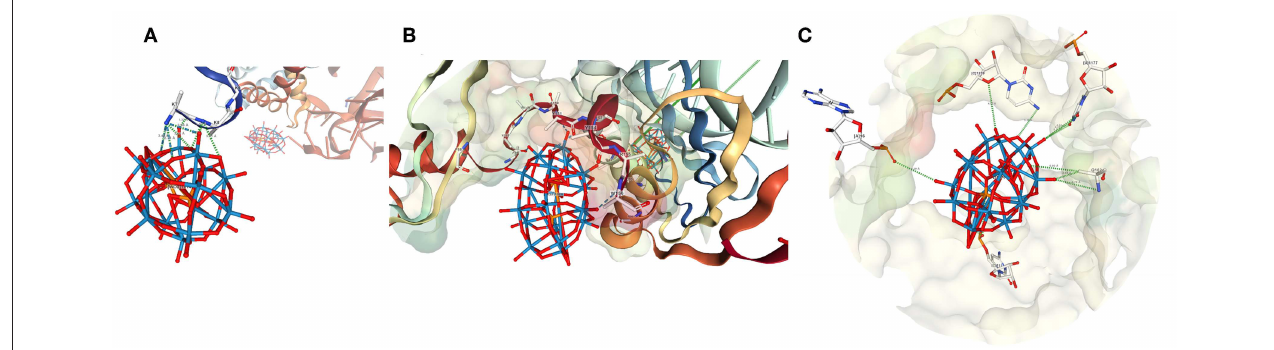
FIGURE 4 | The structure of POMs number (A) 1,014 (B) 1,006, and (C) 1,576 from 1I94. Numbering as shown in Figure 3 (Pioletti et al.,